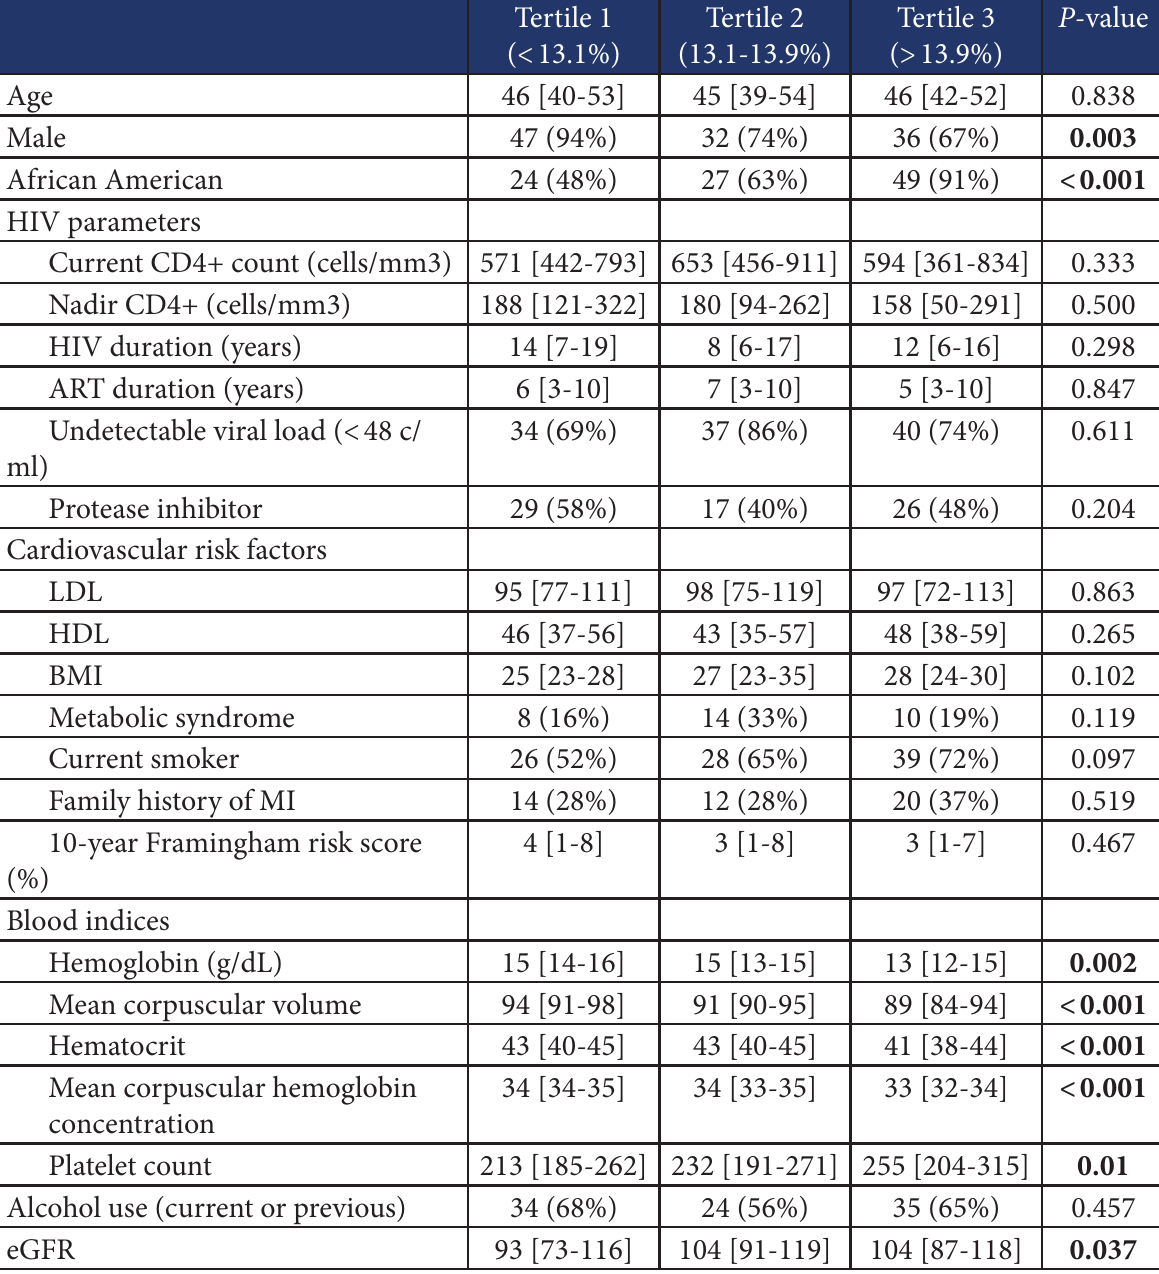
Table 1. Characteristics of the SATURN-HIV study population by tertile of baseline red cell dis- tribution